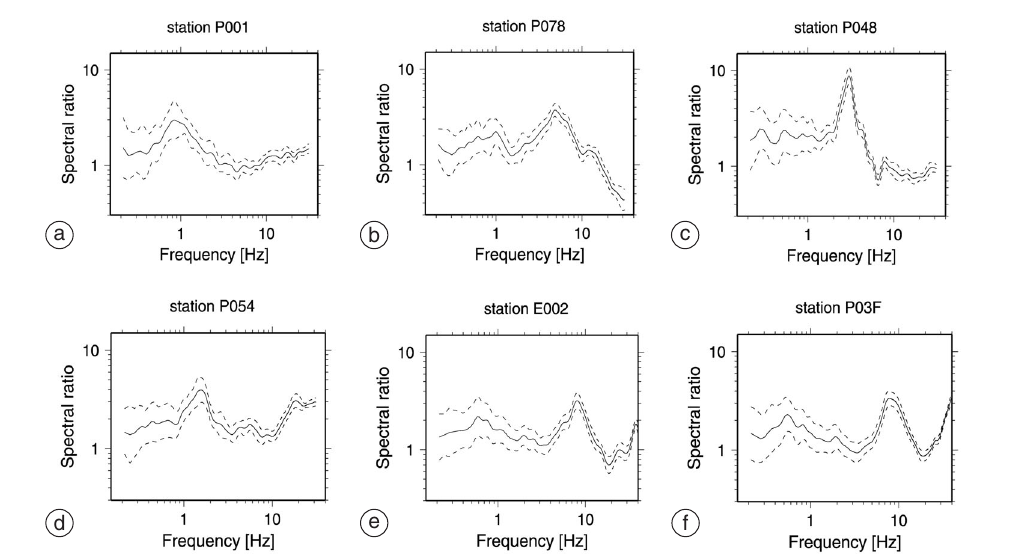
Fig. 2a-f. Averaged spectral H / V ratios for representative stations; fundamental frequency peak lower than 1 Hz (a), higher than 1 Hz (b, c, d), lower than 1 Hz and secondary peak (e, f). The dashed lines indicate the un- certainty estimate as one standard